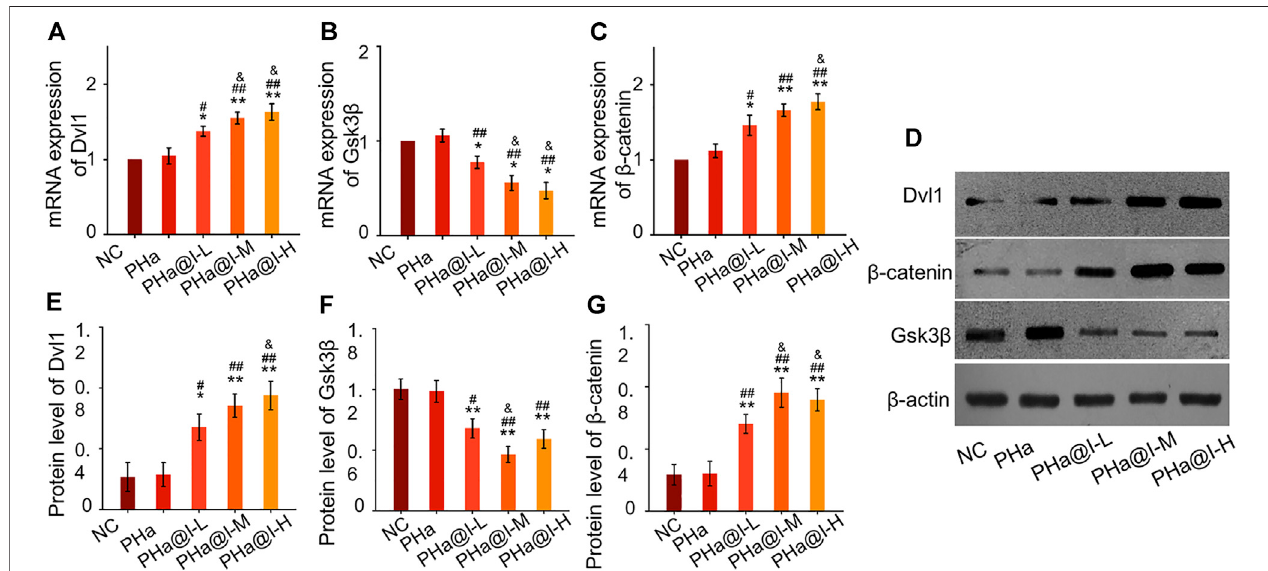
FIGURE 4 | Icariin-loaded hydrogels as 3D cell culture systems activate Wnt/ β -catenin signaling. (A – C) RT-qPCR analysis of Wnt/ β -catenin signaling pathway- related genes Dvl , GSK-3 β , and β -catenin . (D – G) Western blot analysis of Wnt/ β -catenin signaling pathway-related proteins Dvl, GSK-3 β , and β -catenin (* p < .05 and ** p < .01 compared with the NC group; # p < .05 and ## p < .01 compared with the PHa Group; & p < .05 compared with the PHa@I-L Group, n =